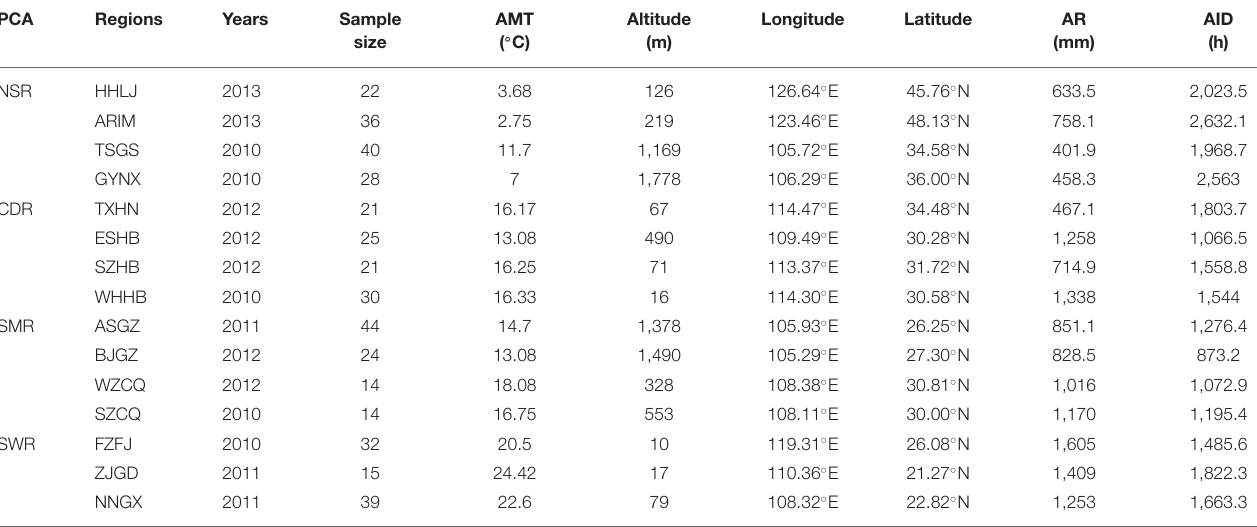
TABLE 1 | Climatic conditions and their associated geographic coordinates of the collection sites for the 15 Phytophthora infestans populations used in the study. PCA Regions Years Sample